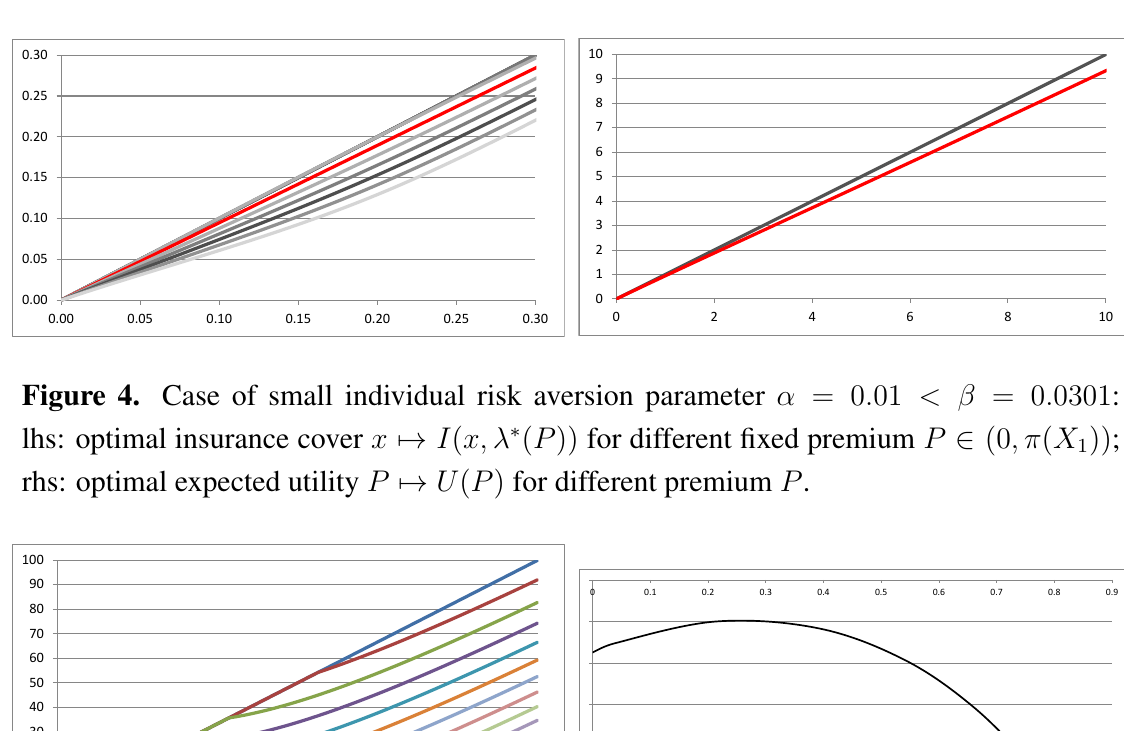
Figure 3. Case of large individual risk aversion parameter α = 0 . 4 > β = 0 . 0301 : the red line illustrates the optimal insurance cover x (cid:55)→ I ∗ ( x ) = I ( x, λ ∗ ( P ∗ )) .